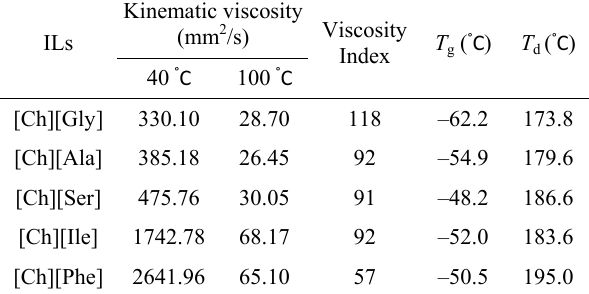
Fig. 2 DSC (a) and TG (b) curves of [Ch][AA] ILs. Table 1 Physical properties of [Ch][AA]